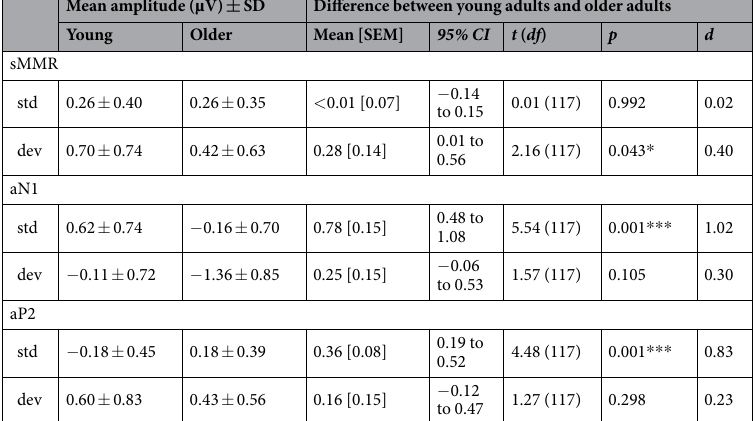
(Table 2, Figs 1 and 2). For all components—sMMR, sP3a, aN1, aMMN, and aP2ta—the main effect of stim- ulus type was found, indicating that the amplitudes to the deviant stimuli were larger than those to the stand- ard stimuli for all components (Table 3, Figs 1 and 2). An interaction effect of stimulus type × age group was found for sMMR, aN1, and aP2 (Table 2, Figs 1 and 2). The following independent samples t -tests (two-tailed, bootstrap statistics) showed that the deviant responses in the sMMR analysis window were attenuated and that the standard responses for aN1 and aP2 were enlarged in older adults compared to young adults (Table 3). The interaction effect of stimulus type × age group for sMMR remained significant after controlling for stimulus intensity ( p = 0.019); similarly, the interaction effect for aP2 was significant when controlling for hearing thresh- old ( p = 0.005), but hearing threshold as a covariate decreased the p value of the interaction effect of stimulus type × age group for aN1 ( p = 0.055).